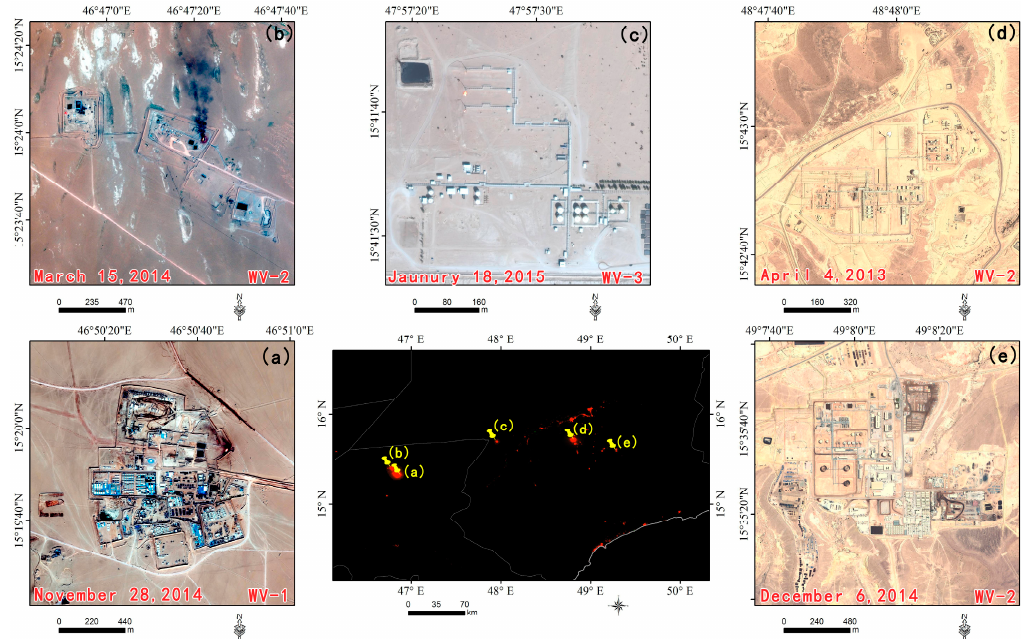
Figure 14. Validation of the oil exploration in Shabwah and Hadramawt: ( a , b ) represent oil exploration areas in Shabwah, and ( c – e ) represent oil exploration areas in Hadramawt.